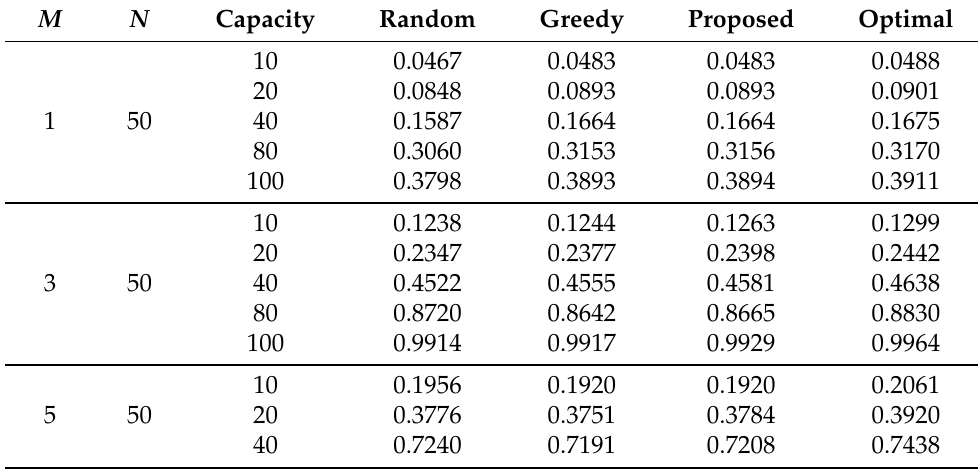
Table 2. Profit ratio of selected items for LI set.